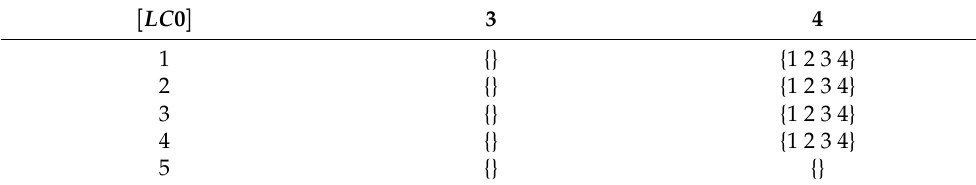
{} {} {} {} Table 7. Layers of the cycles no bigger than the double of the diameter for Figure 1.